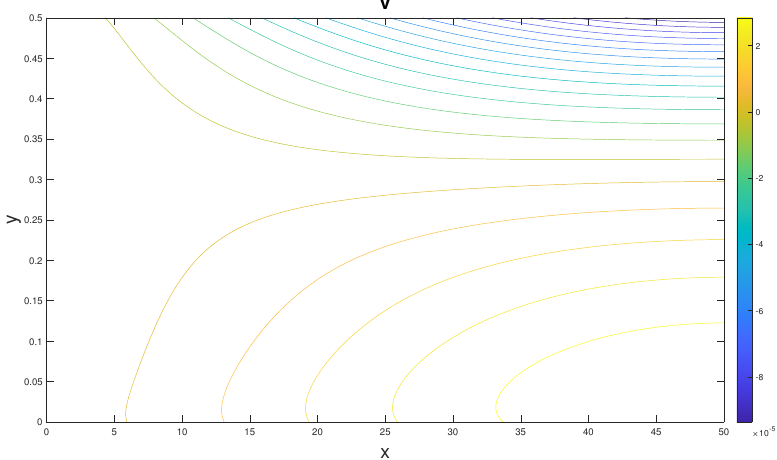
Figure 12. Contour plot of the v -velocity profile at t =